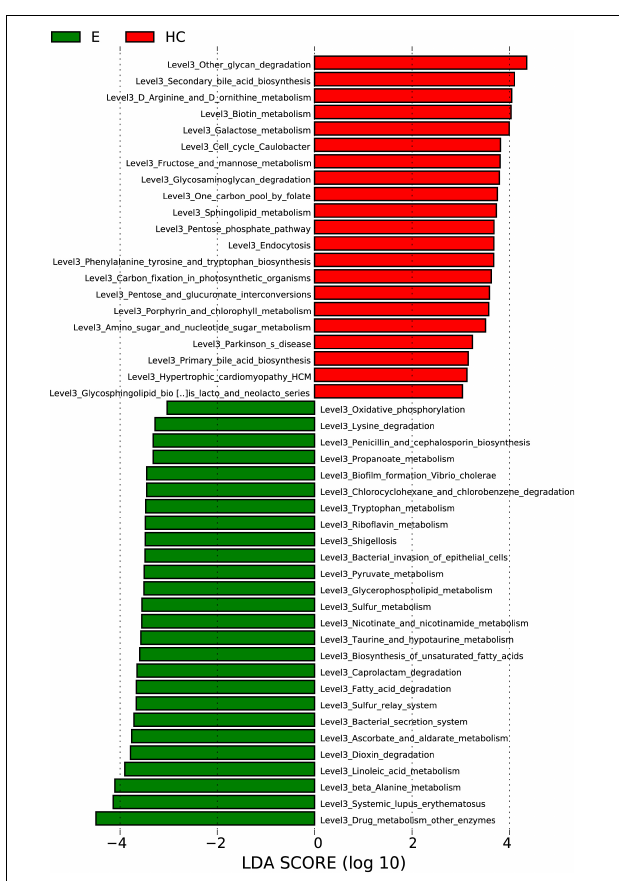
FIGURE 7 | Functional analysis of predicted metagenomes. Differentially abundant KEGG pathways across Eps ( n = 24) and HCs ( n = 50) identified by the LEfSe method. Histogram of LDA scores calculated for selected pathways showing significant differences in gene functions between Eps (green) and HCs. LDA scores on a log10 scale are indicated at the bottom. The significance of the microbial marker increases with the LDA score. Eps, patients with epilepsy; HCs, healthy controls; OTUs, operational taxonomic units; LEfSe, linear discriminant analysis effect size; LDA, linear discriminant